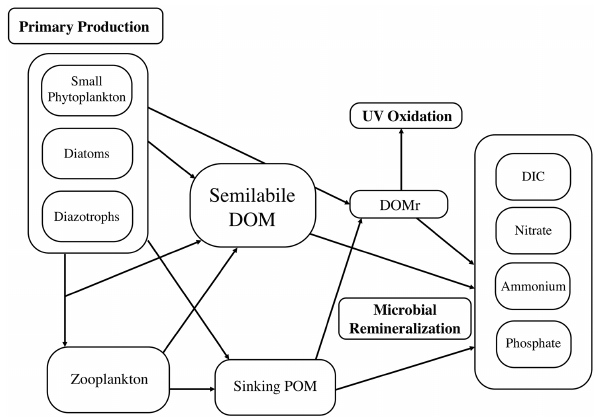
Figure 1. Schematic of organic matter cycling in the CESM BEC. Primary production is carried out by three phytoplankton functional types: small phytoplankton (which also contains a subgroup of cal- cifying phytoplankton), diatoms, and diazotrophs. Sources to DOM include direct losses from phytoplankton/zooplankton and from zooplankton grazing of phytoplankton. The major sink for DOM is microbial remineralization, parameterized with an assigned lifetime which differs between the euphotic zone and the mesopelagic ocean. A small fraction of phytoplankton production is converted to refrac- tory DOM in the upper ocean with an additional source to DOMr from degradation of sinking POM in the mesopelagic. DOMr is also lost via UV photo-oxidation in the surface layer (<10m). The prod- ucts of organic matter remineralization are dissolved inorganic car- bon, nitrate, ammonium, and